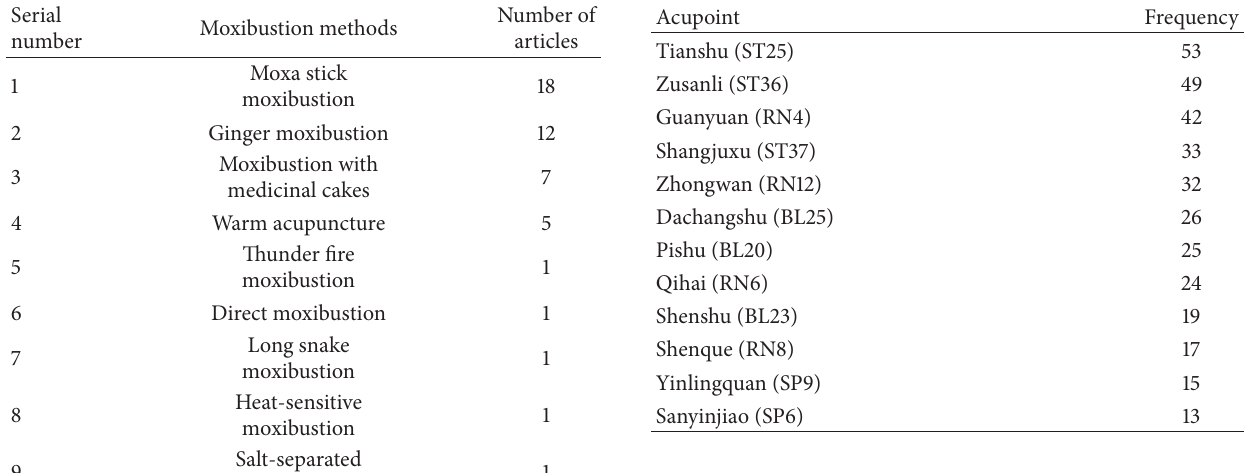
Table 5: Statistical results of commonly used